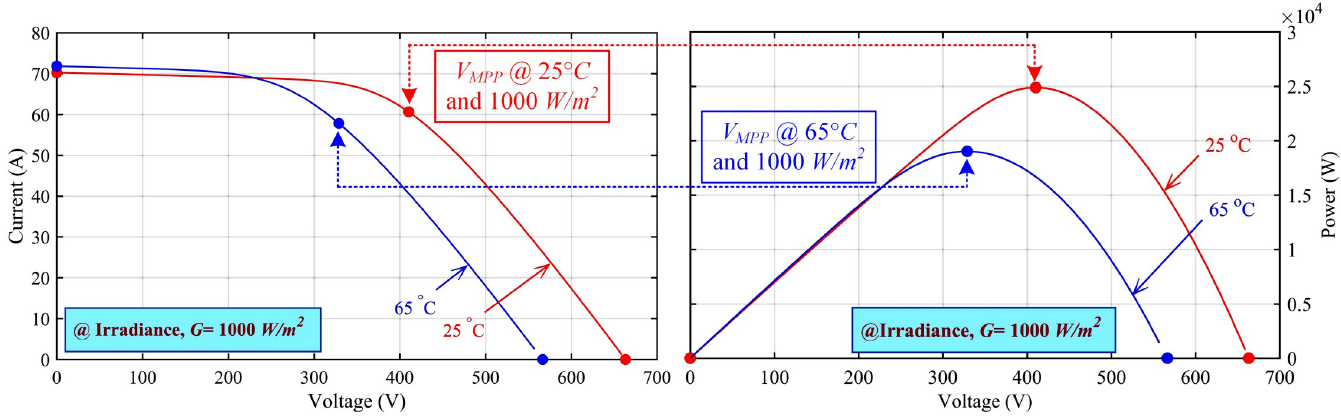
Fig 5. Electrical characteristics of the PV array.